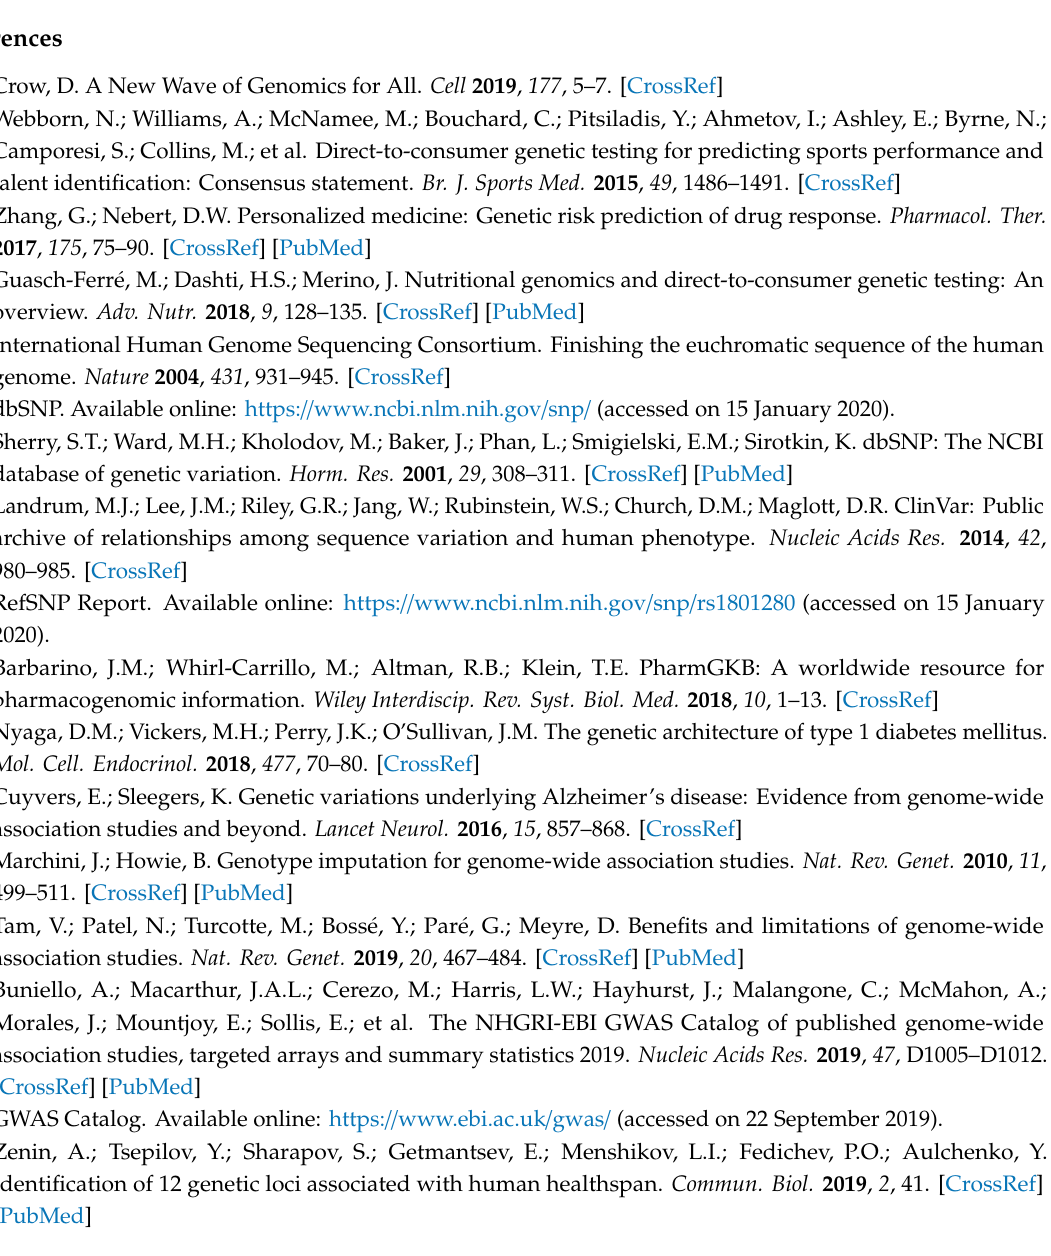
Table S1: table of traits analyzed by DTC-GT, Table S2: table of genes and variants of interest, Table S3: table of GWAS catalog results, Table S4: table of Clinvar